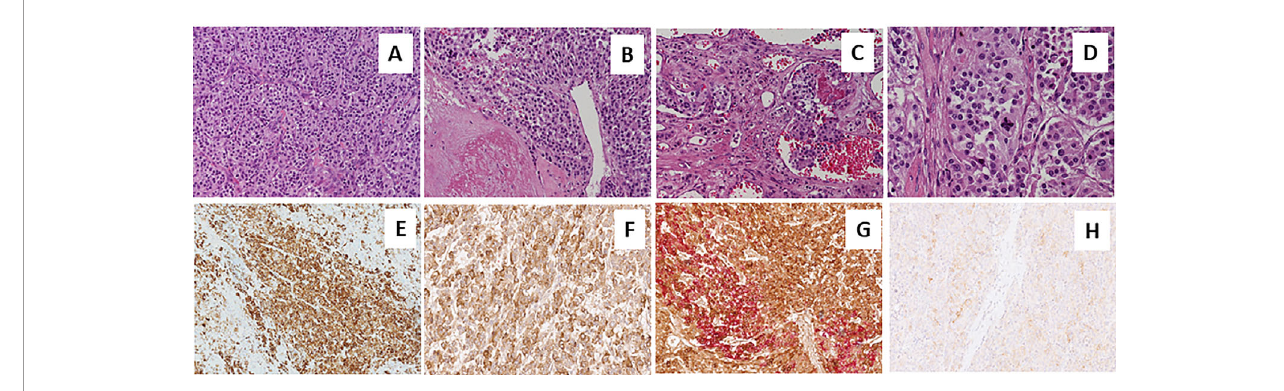
FIGURE 2 | Sections from right adrenal gland Morphologic analysis with hematoxylin-eosin staining in (A – D) at different magni fi cation. Panels show a pheochromocytoma, with a typical zellballen pattern of growth ( A , 20X), with perivascular cell cuf fi ng around a blood vessel called pseudo-rosette pattern ( B , 20X), with neoplastic cells inside vascular spaces ( C , 20X), and at greater magni fi cation ( D , 40X), an atypical mitotic fi gure. Positive immunohistochemical staining of Chromogranin A in Panel (E) , VIP (F) and anti-Somatostatin Receptor 2A (SSTR2A, H ). Double immunostaining showing the co-expression of Chromogranin A (brown) and VIP (red) (G) .